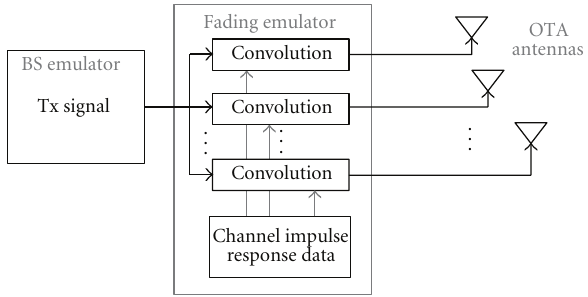
Figure 2: Convolution of Tx signal and radio channel impulse response data in the fading